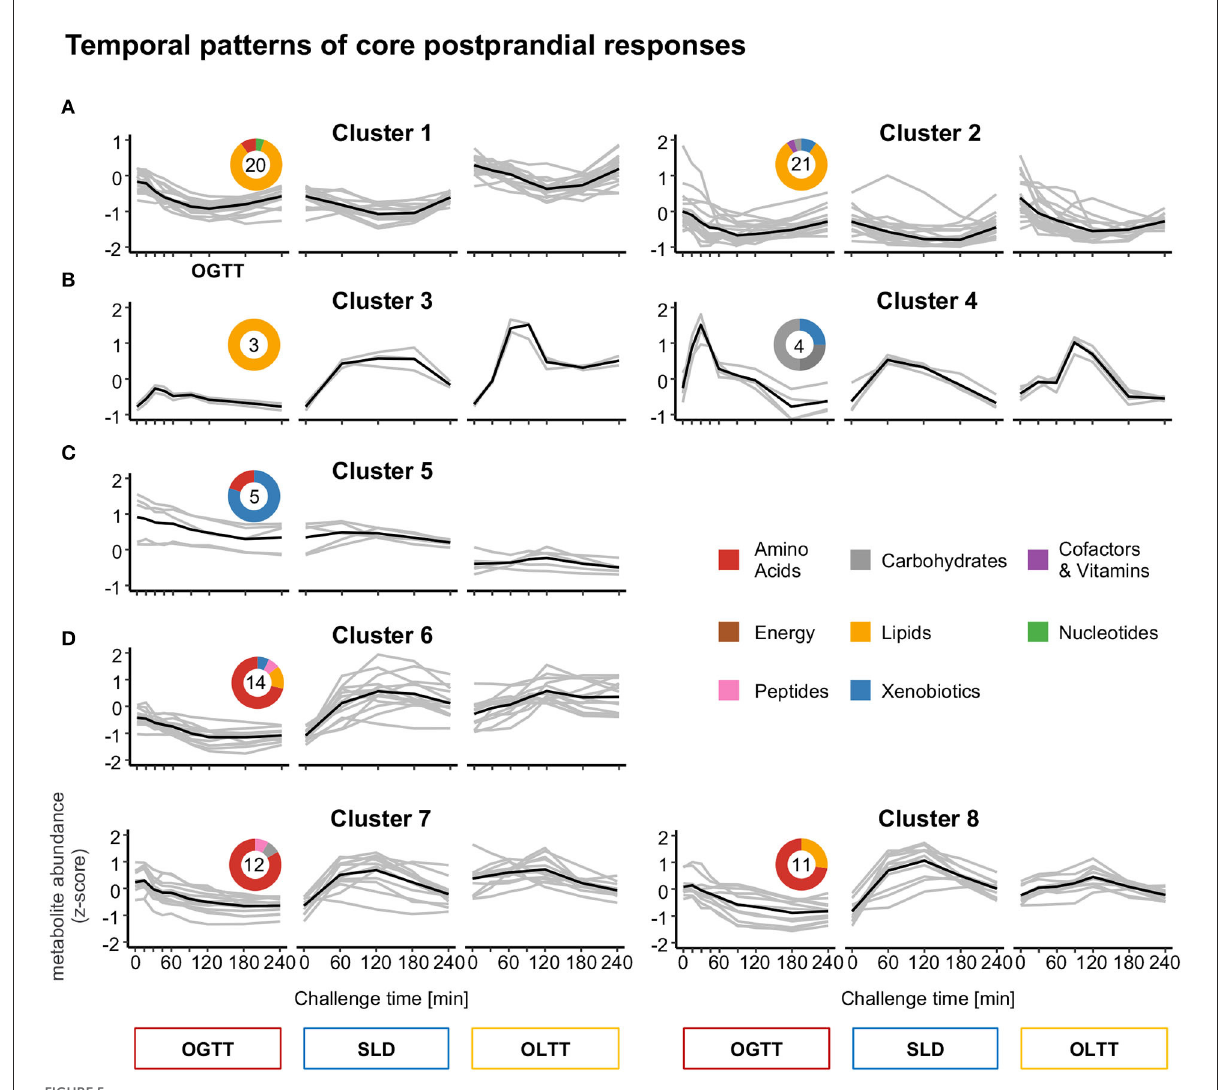
FIGURE5 Temporal patterns of core postprandial responses identified by fuzzy c-means cluster analysis. Graphs show four general patterns of responses (A–D) . The black line depicts the mean z-score of trajectories over the 15 participants for each metabolite in a cluster. The colored donuts depict the distribution of metabolites in a cluster over the eight metabolite classes. (A) Metabolic responses (Cluster 1, 2) with postprandial decreases and increases from baseline until 4h. (B) Responses with postprandial increases and decreases (Cluster 3, 4) from baseline until 4h. (C) Response with steady decreasing trajectories (Cluster 5) from OGTT to OLTT. (D) Dissimilar metabolic responses in OGTT compared to SLD/OLTT (Cluster